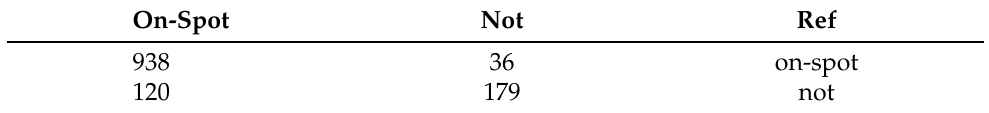
Table 5. Confusion Matrix from SVM classifier.